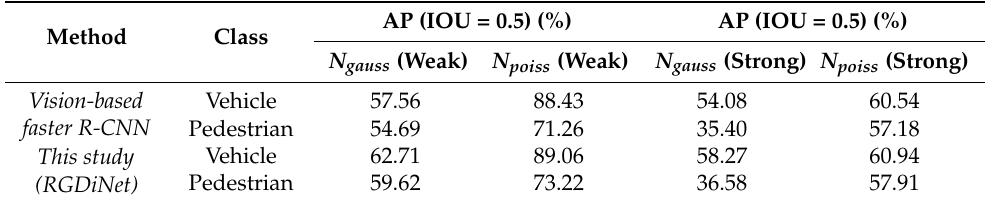
Table 4. Performance comparison of object detectors in noisy environment.